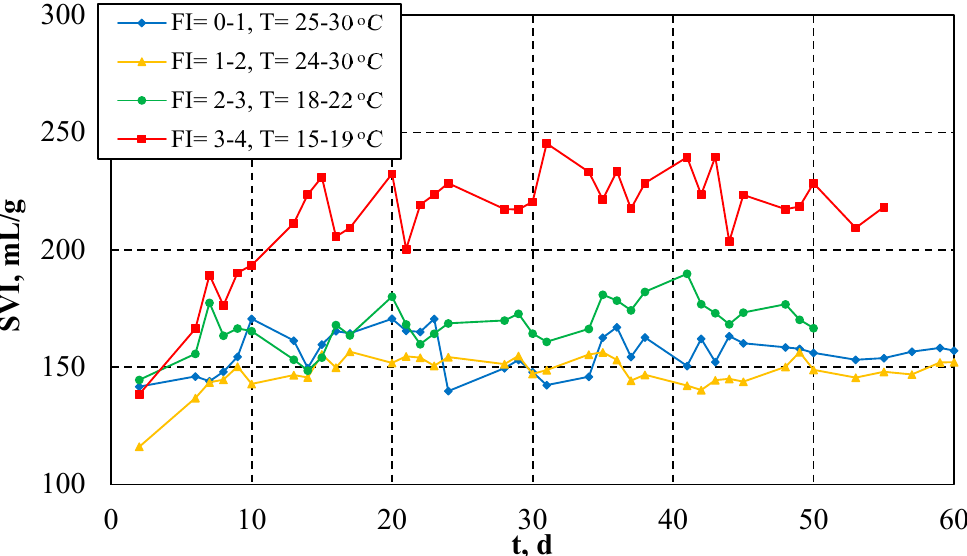
Figure 7. Effect of FI and temperature on sludge settleability (SVI).